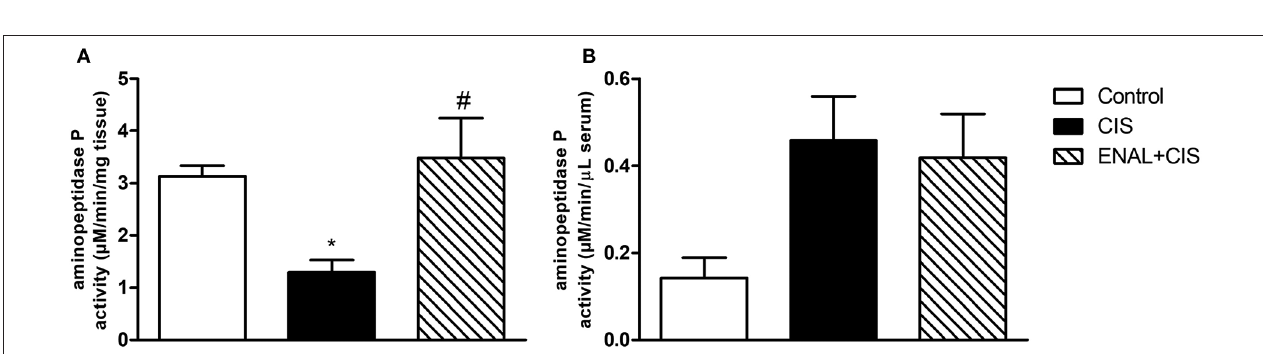
FIGURE 3 | (A–E) Renal mRNA expression of RAS and KKS receptors and ACE. The panels show the daily renal mRNA expression after cisplatin injection. B1R and B2R = B1 and B2 kinin receptors; AT1R and AT2R = AT1 and AT2 angiotensin II receptors. * p < 0.05. Data presented as Mean ± SEM of fold changes; n = 5–6 per group. CIS = Cisplatin; ENAL + CIS = Enalapril + Cisplatin.